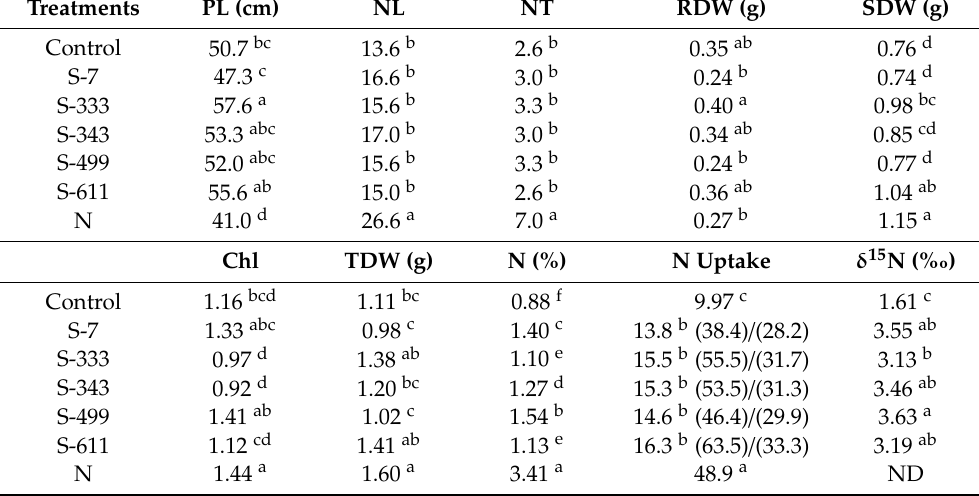
Table 4. Pearson’s correlation between upland rice growth parameters at 30 DAI under growth chamber conditions. Plant length (PL), number of leaves (NL), root dry weight (RDW), shoot dry weight (SDW),